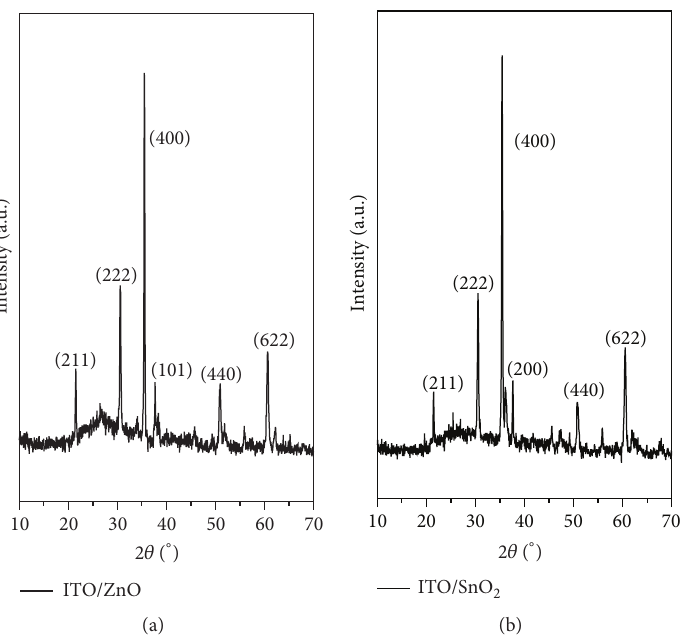
F 2: XRD spectrum of ITO/ZnO and ITO/SnO